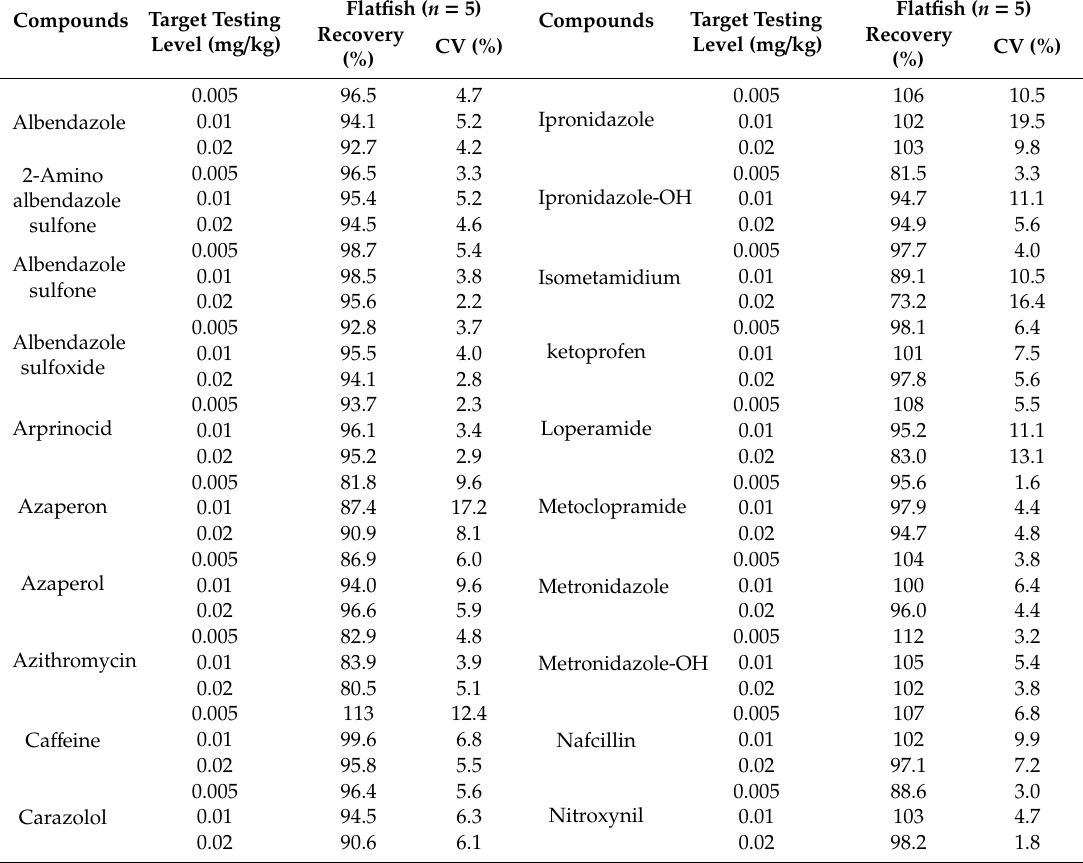
Table 3. Recovery and CV (coe ffi cient variation) at target testing levels in